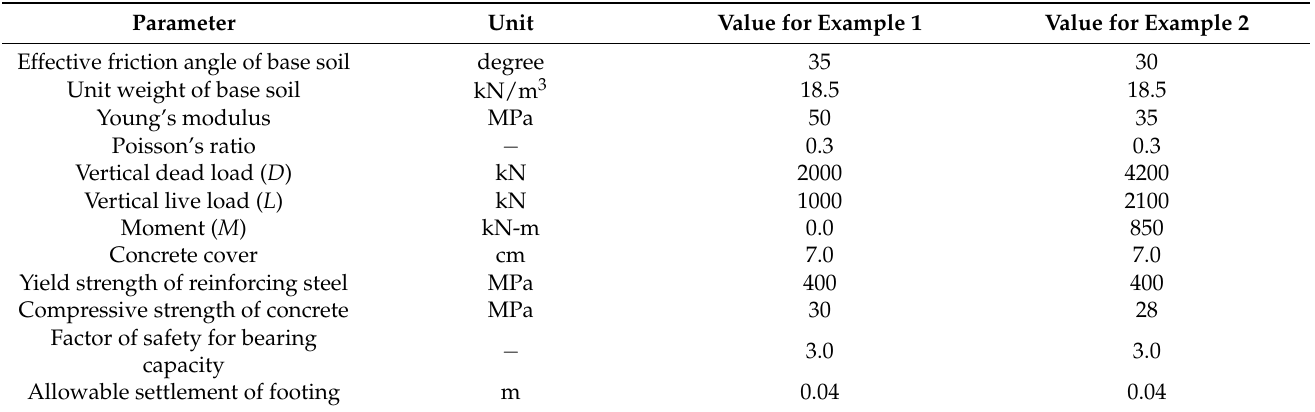
Table 14. Input parameters for design examples 1 and